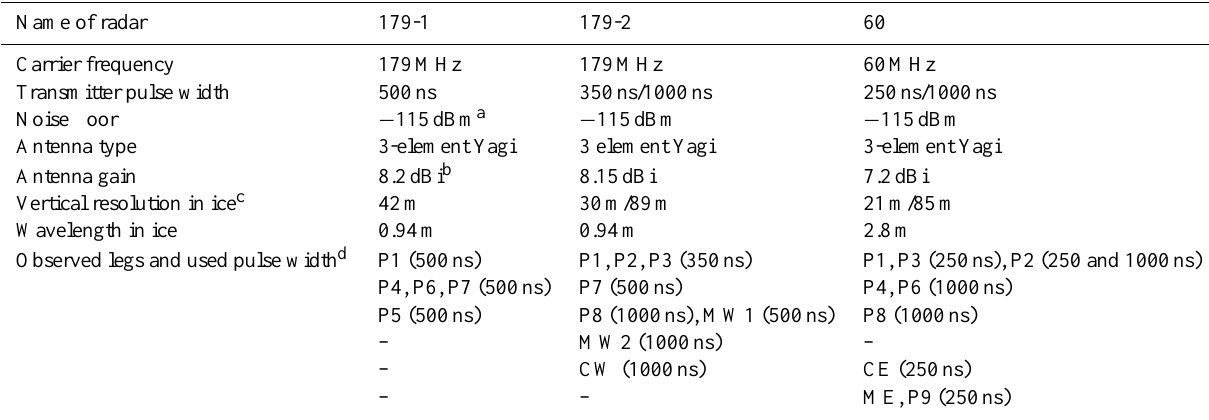
a dBm is a unit of power level in decibels with reference to a power of 1mW. Receiver sensitivity assumes averaging to reduce the noise level. b dBi is a unit of antenna gain in decibels with reference to the power of an ideal isotropic antenna. c Vertical resolutions are the wave travel distances for half of the pulse width. d Numbers in brackets show pulse width used along each leg. See text.